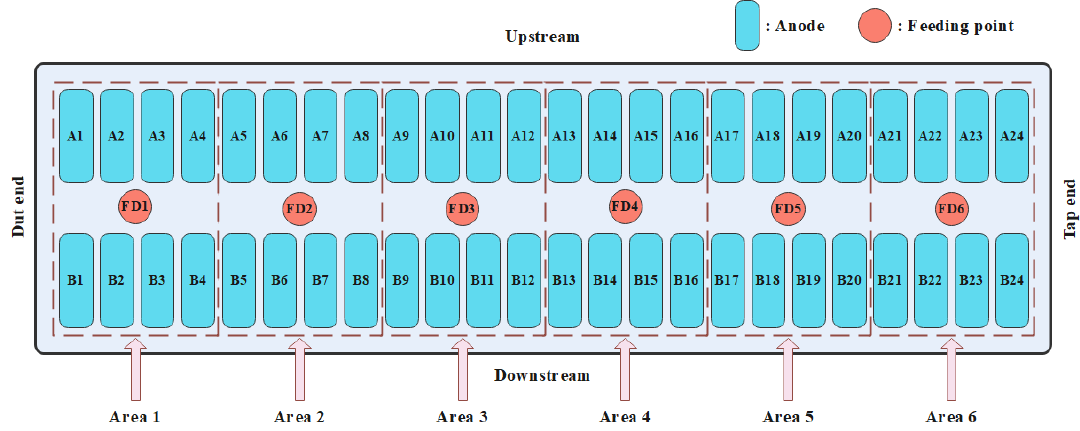
Figure 2. Partition diagram of anode rod of 400 kA aluminum reduction cell.